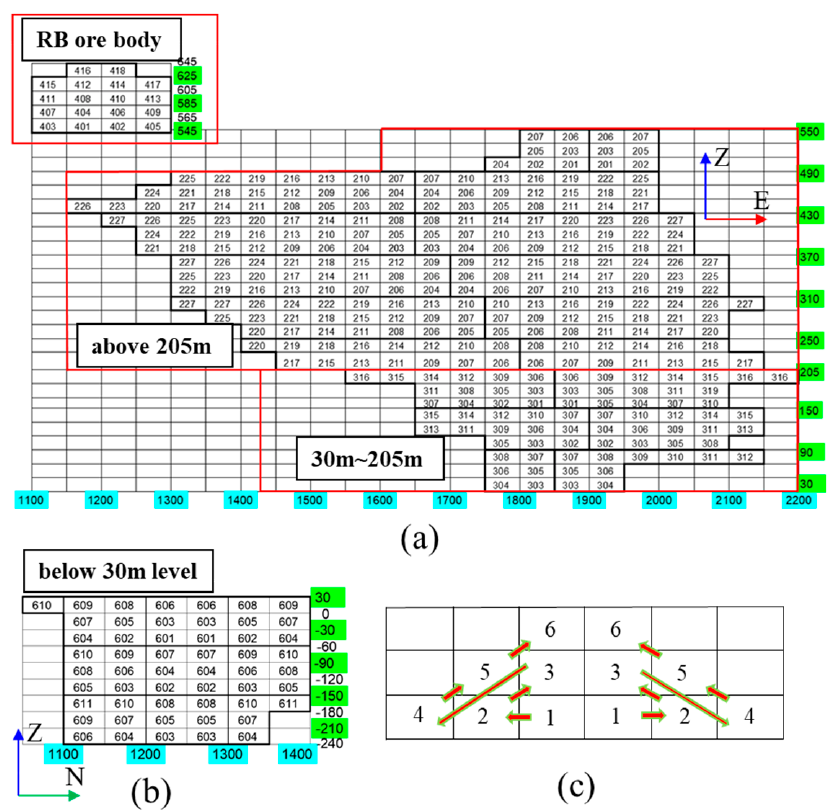
Figure 10. Stopes distribution and mining sequence in the same level ( a ) Stopes distribution above 30 m levels; ( b ) Stopes distribution blow 30 m levels; ( c ) Mining sequence in the same level.